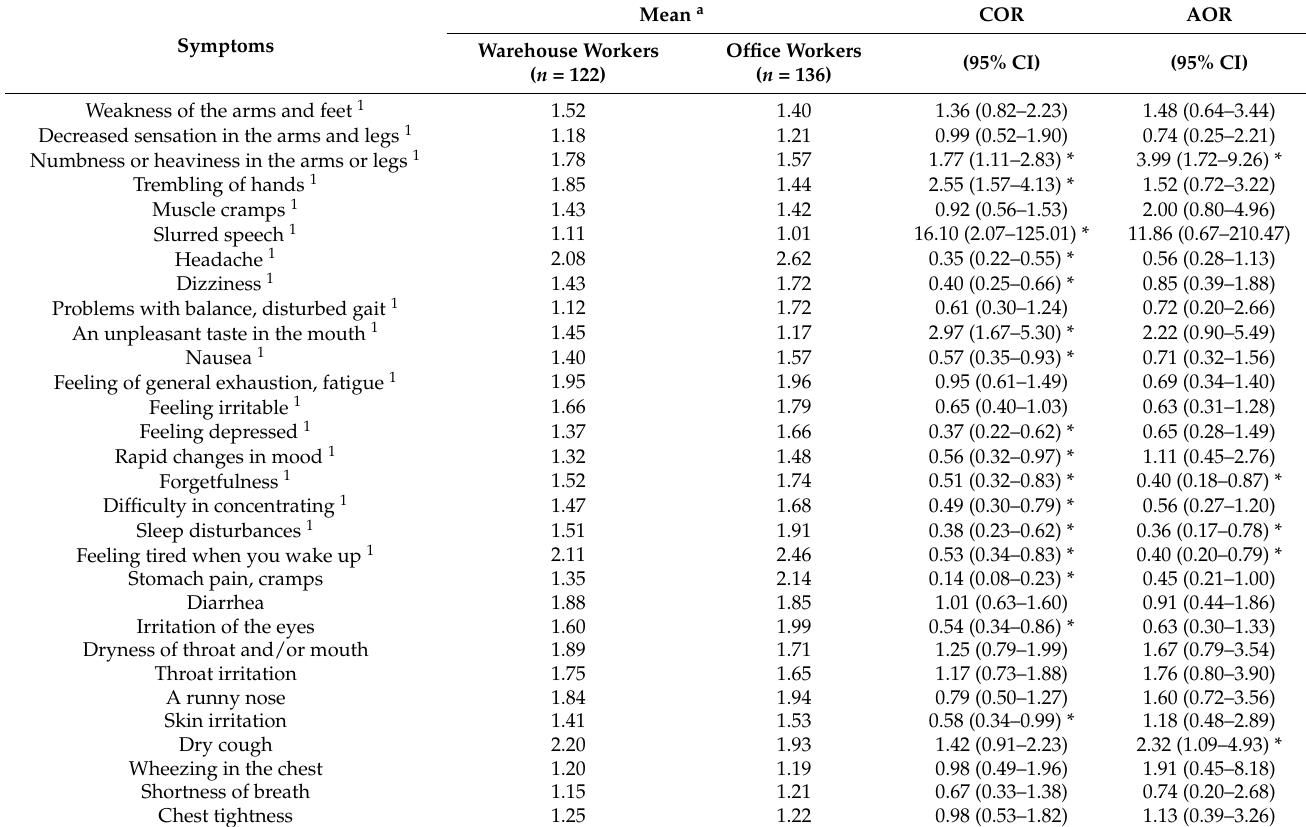
Table 3. Symptoms among warehouse and office workers at logistics